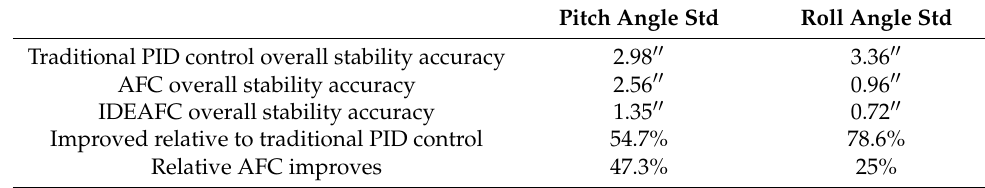
Table 2. Comparison of control effects under static conditions.